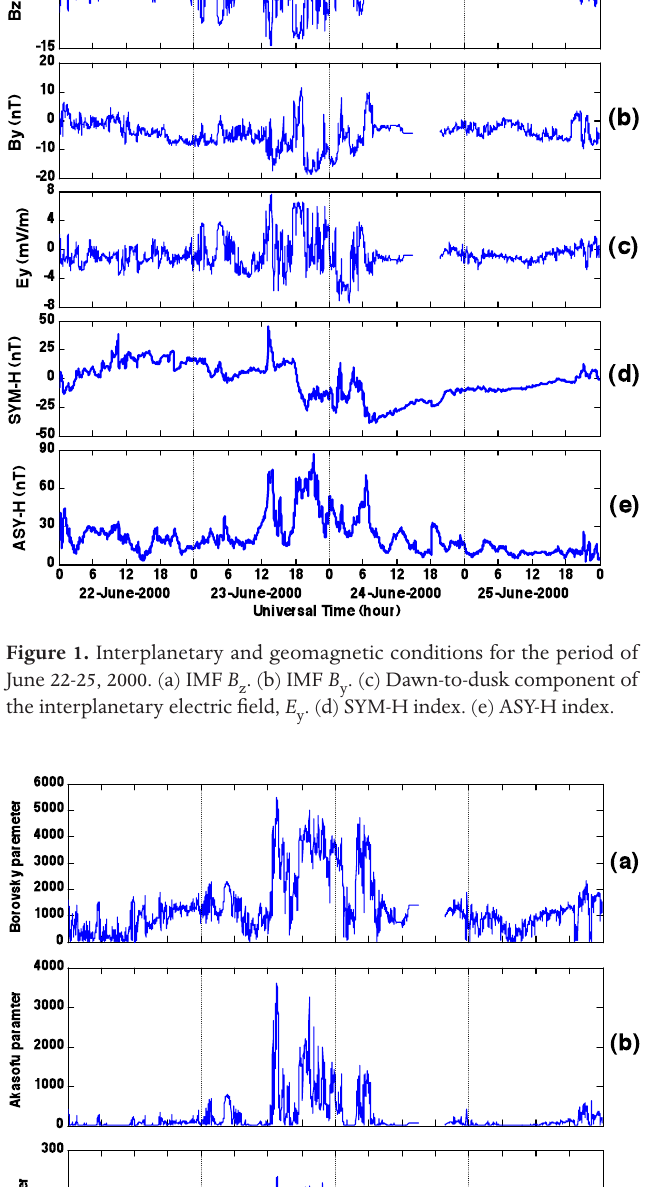
Figure 2. Solar wind energy input using coupling functions for June 22-25, 2000. (a) The Borovsky parameter. (b) The Akasofu parameter. (c) The Newell